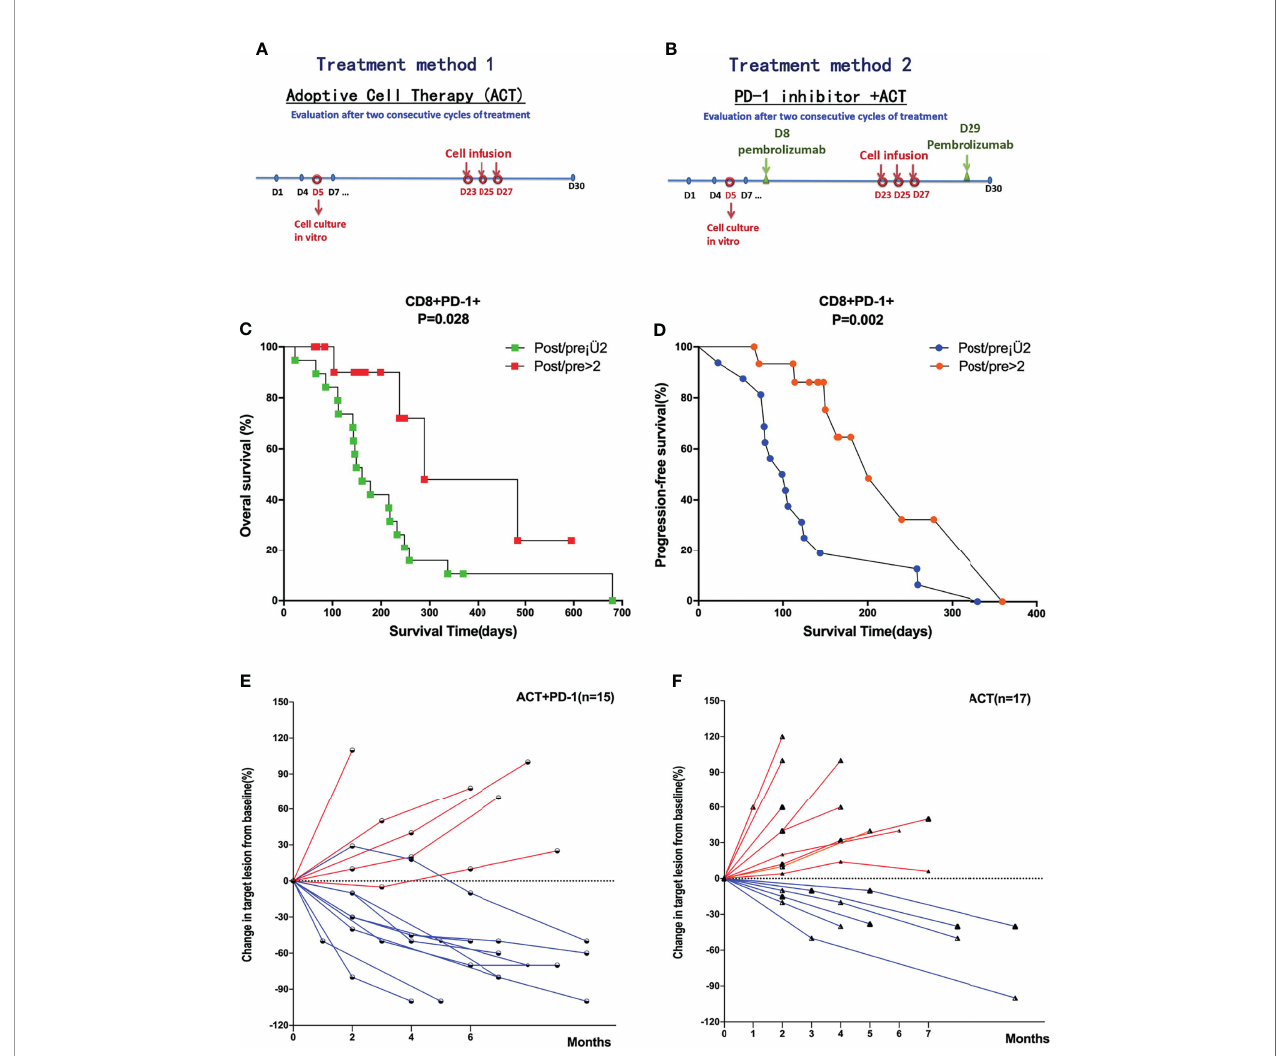
FIGURE 3 | Survival analysis of subgroups divided by the treatment methods and level of CD8 + PD-1 + T cells. (A) Treatment method of ACT in all patients with APC. (B) Treatment methods for patients received ACT combined with anti-PD-1. (C, D) Patients with post/pre > 2 of CD8 + PD-1 + T cells had signi fi cantly favorable OS and PFS compared with post/pre ≤ 2 of CD8 + PD-1 + T cells. (E, F) The change of the targeted lesion detected by CT or MRI in patients who received ACT combined with anti-PD-1 and solely ACT, respectively. ACT, adoptive T-cell therapy; APC, advanced pancreatic cancer; OS, overall survival; PFS, progression-free